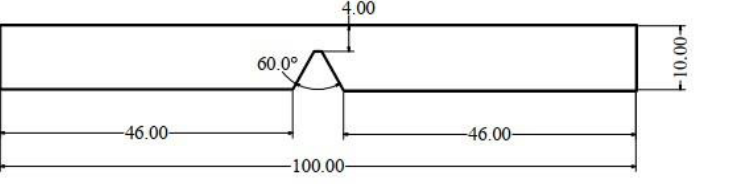
Figure 1: Schematic of notched